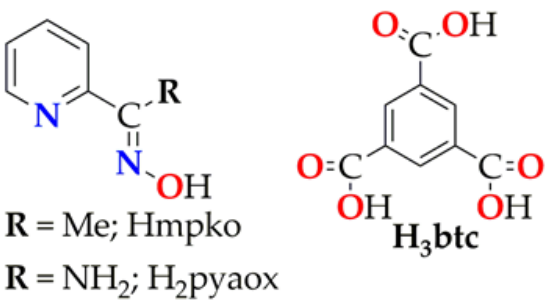
Scheme 1. Schematic representation of the 2-pyridyl oximes ( left ) and the ligand H 3 btc ( right ) discussed in this